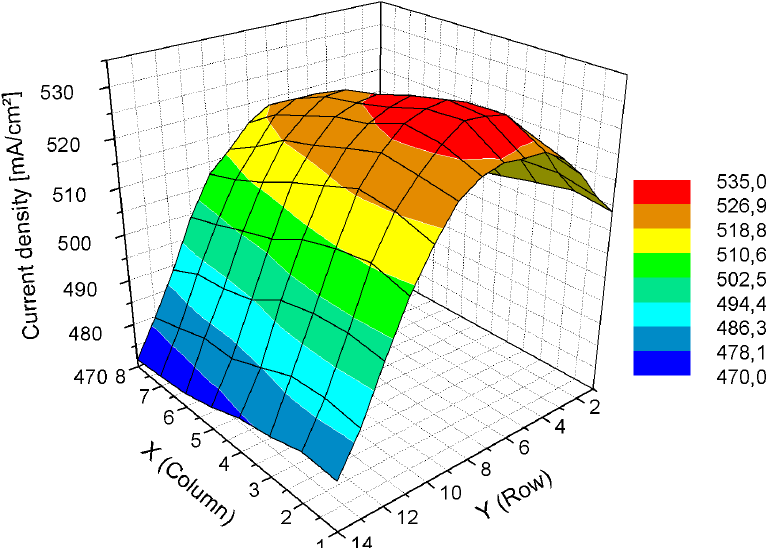
Figure 14 . Current density distribution for 100 A load current. H2 = 3254